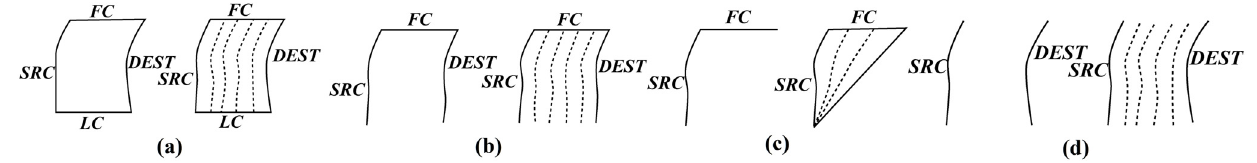
Figure 11. Four basic types of morphing methods (the dashed lines are the transition curves generated by interpolation). ( a ) four-edge type; ( b ) three-edge type; ( c ) two adjacent-edge type; ( d ) two opposite-edge type.